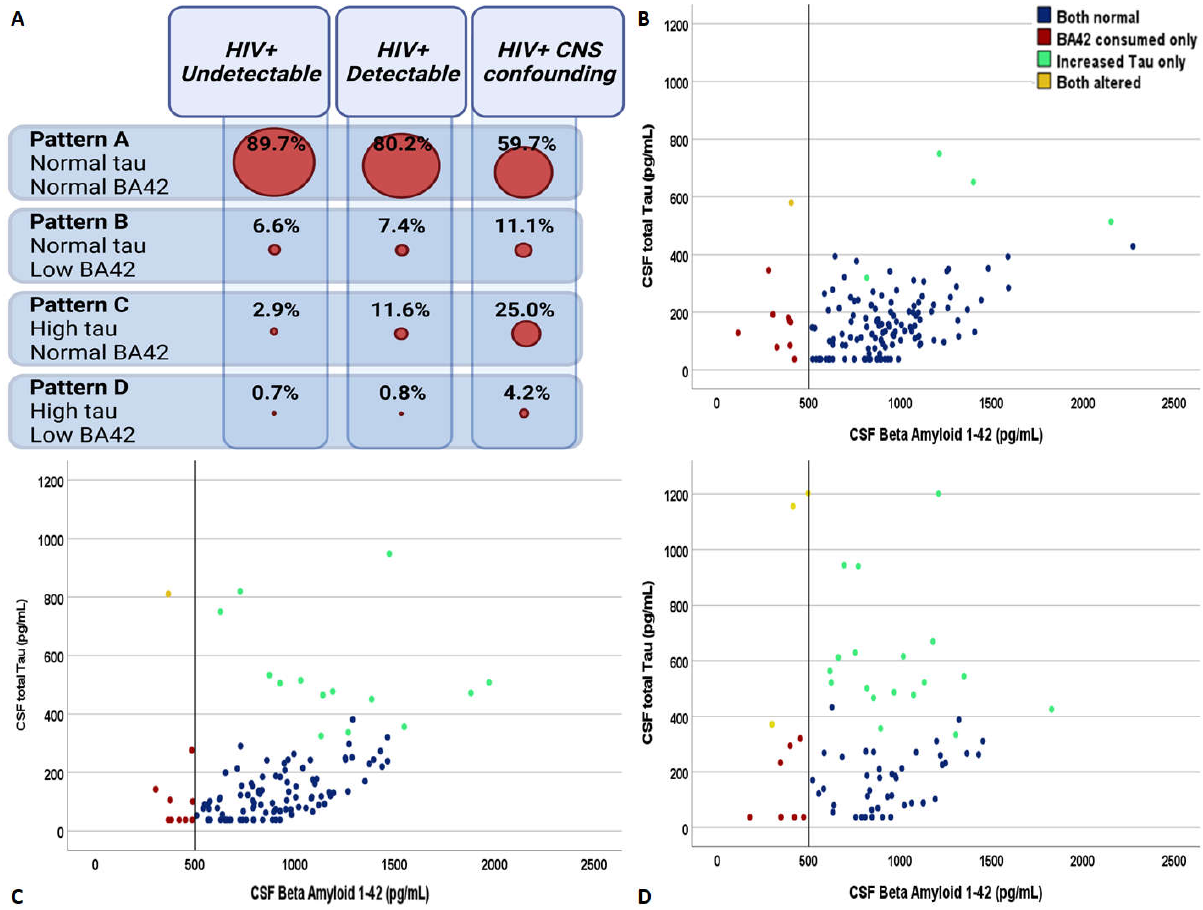
Figure 1. The distribution of the four patterns of cerebrospinal fluid biomarkers of Alzheimer’s dementia across the spectrum of HIV-related clinical conditions. Panel ( A ) shows the relative distribution of the four biomarker groups in the three clinical categories. Panel ( B – D ) describe the distribution of the study subjects identified according to the cross-combination of CSF total tau and beta amyloid 1–42 in the group of PLWH with undetectable plasma viremia, with detectable plasma viremia, and with neurological confounding conditions regardless of plasma viremia, respectively. Blue dots = subjects with CSF pattern A, red dots = subjects with CSF pattern B, green dots = subjects with CSF pattern C, and yellow dots = subjects with CSF pattern D.